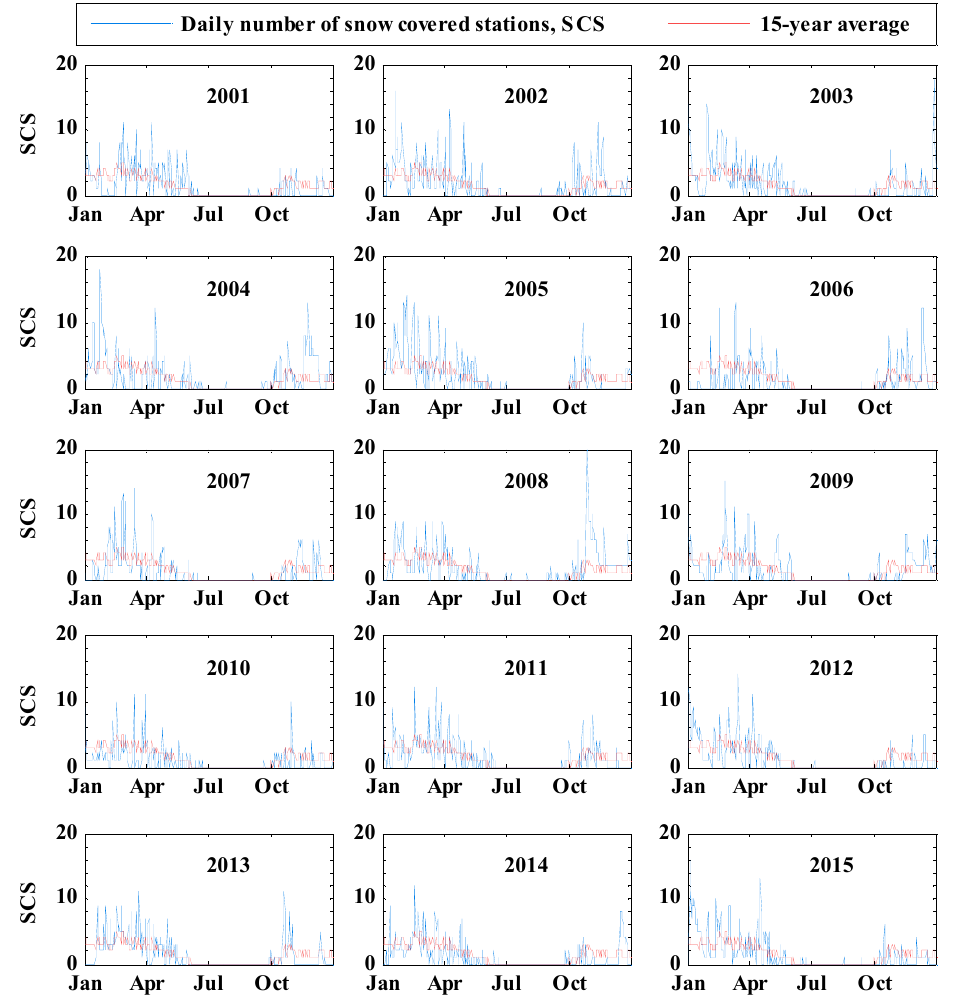
Figure 8. Daily values for individual years (blue) and for the average year (red) of the number of snow-covered stations. Table 5. Average and maximum numbers of daily snow-covered stations in Tibet during 2001–2015.